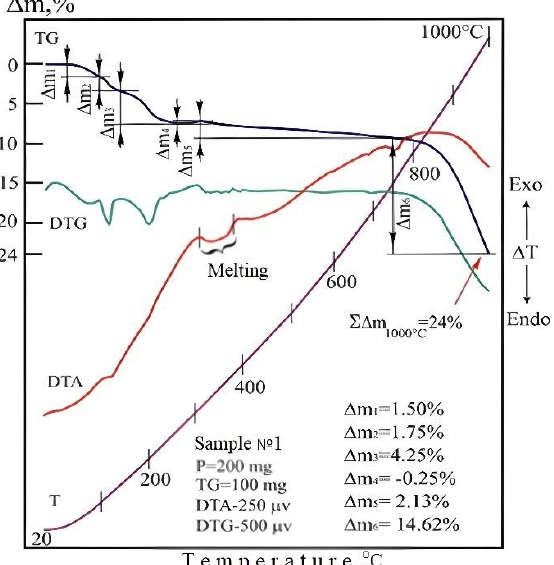
Figure 4. Thermogravimetric readings of lead sludge at 20–1000 °C with 40–85 °С change in sample mass: ∆m 1 = −1.50%, -H 2 O; at 85–155 °С;—∆m 2 = −1.75%, -H 2 O; at 155–240°С—∆m 3 = −4.25%, -СO 2 ; - mass: ∆ m 1 = − 1.50%, -H 2 O; at 85–155 ◦ C; - ∆ m 2 = − 1.75%, -H 2 O; at 155–240 ◦ C— ∆ m 3 = − 4.25%, -CO 2 ; H 2 O; at 240–320 °С—∆m4 = +0.25% +O 2 ; at 320–430 °С,—∆m 5 = −2.13%, -СO 2 ; at 740–1000 °С—∆m 6 = -H 2 O; at 240–320 ◦ C— ∆ m4 = +0.25% +O 2 ; at 320–430 ◦ C,— ∆ m 5 = − 2.13%, -CO 2 ; at 740–1000 ◦ C— −14.62%—SO 2 , sublimation; at 20–1000 °C sample mass change in total ∆m = −24.00%. ◦ C sample mass change in total ∆ m = − ∆ m − 14.62%—SO 6 = 2 , sublimation; at 20–1000